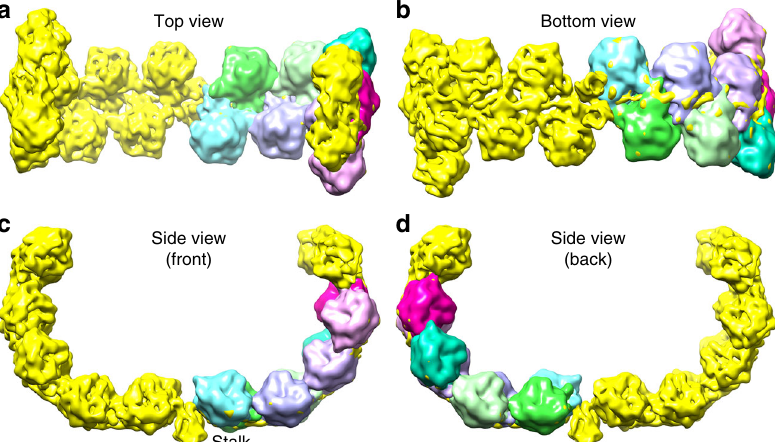
Fig. 4 The spike. a – d show four views. One horn is shown with the raw density (yellow), whilst the other is clothed by eight VP3 pearl-like domains, where the density shown is averaged across all the pearls and the contour level is set to give the correct volume for a protein the size of VP3 (for details see text and Methods). Note that the pearl orientations present a common face to the concave inner surface of the horns, presumed to be the receptor-binding face. The contour level of the map raw density is set at a higher level, to make structural features